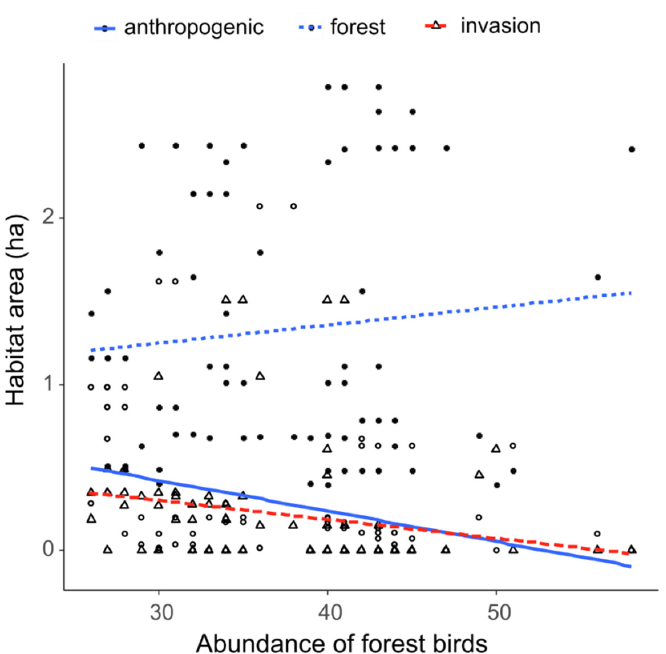
Figure 5. Graph showing the significant effects of forest area, Caucasian hogweed invasion area and anthropogenic area on the abundance of forest birds; habitat variables were measured in a radius of 100 m from the survey points (number of sites: N = 38).